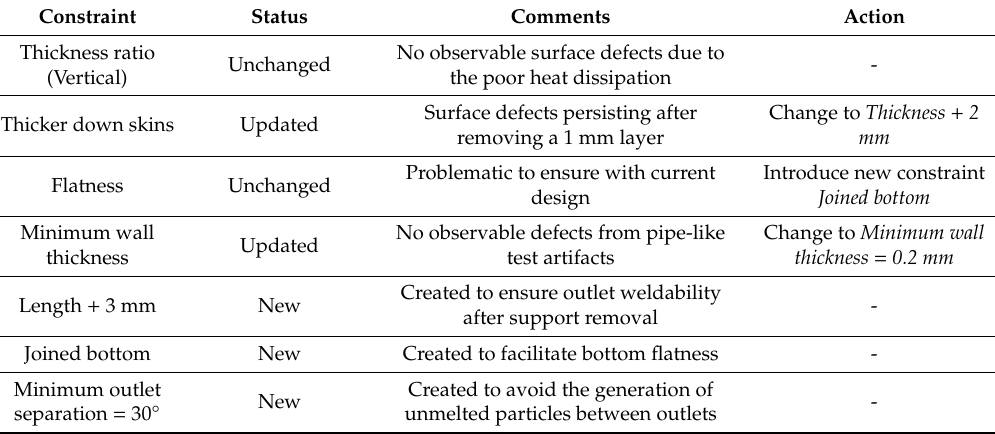
Table 3. Lessons learned from the prototyping